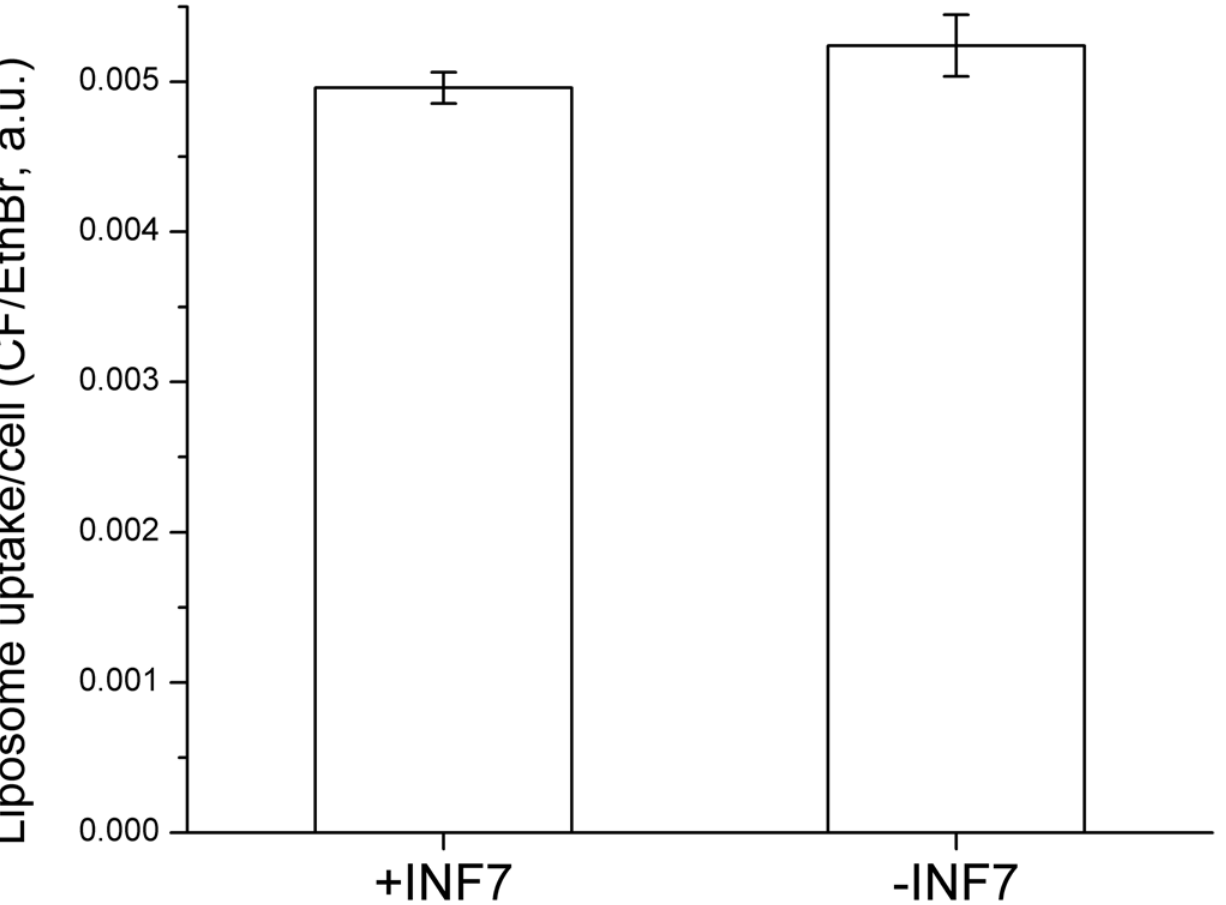
Fig 6. Liposomal encapsulation of INF7 does not alter the quantity of liposomes endocytosed by CV1 cells. Liposomes containing CF-PE as a lipid marker of endocytosis, with and without INF7, were incubated with CV1 cells for 1 hr. After incubation, cells were washed with Ca 2+ /Mg 2+ -free PBS containing 1 mM EDTA to release un-endocytosed liposomes. Cells were then lysed and measured for CF fluorescence that was then normalized to DNA content measured by ethidium bromide (EthBr) fluorescence. The means are not significantly different ( p = 0.25; n =